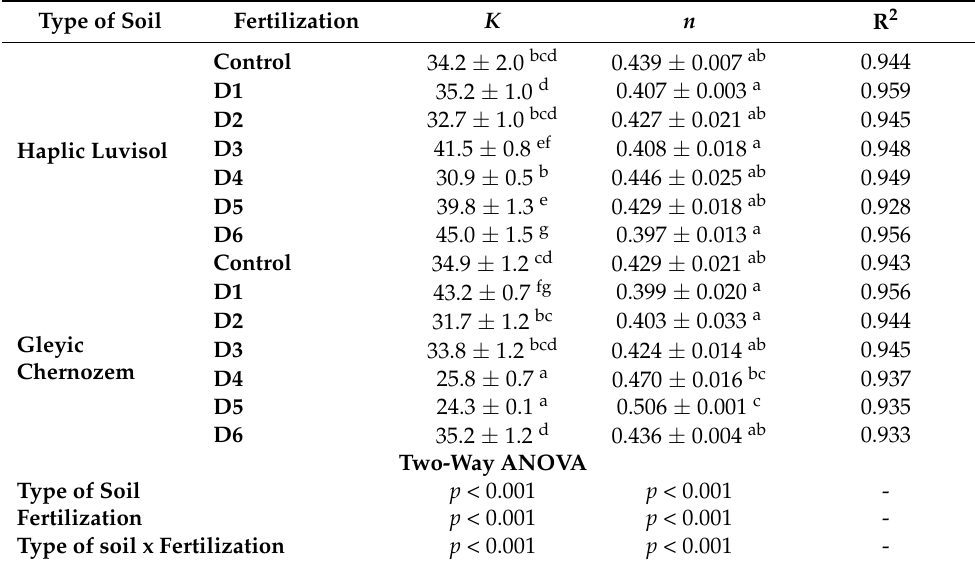
Table 5. Parameters of power law equations describing flow of potato starch pastes. Type of Soil